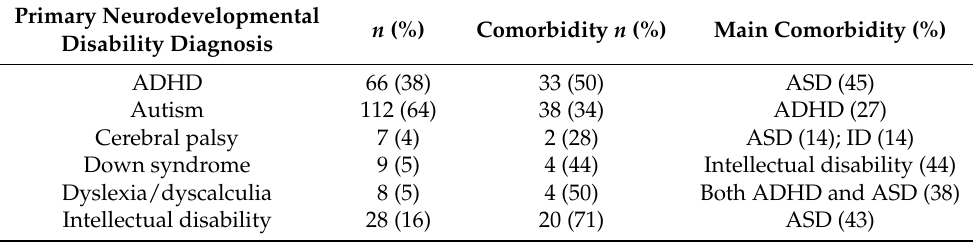
Table 2. Neurodevelopmental disability characteristics. Primary